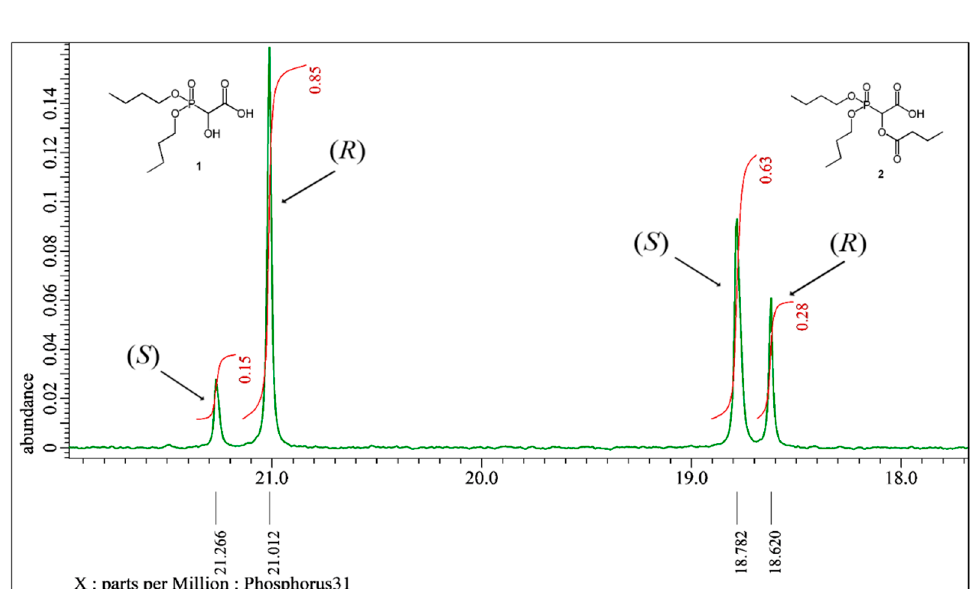
Figure 1. 31 P NMR spectrum of products after biotransformation of dibutyl 1-butyryloxy-1-carbox-